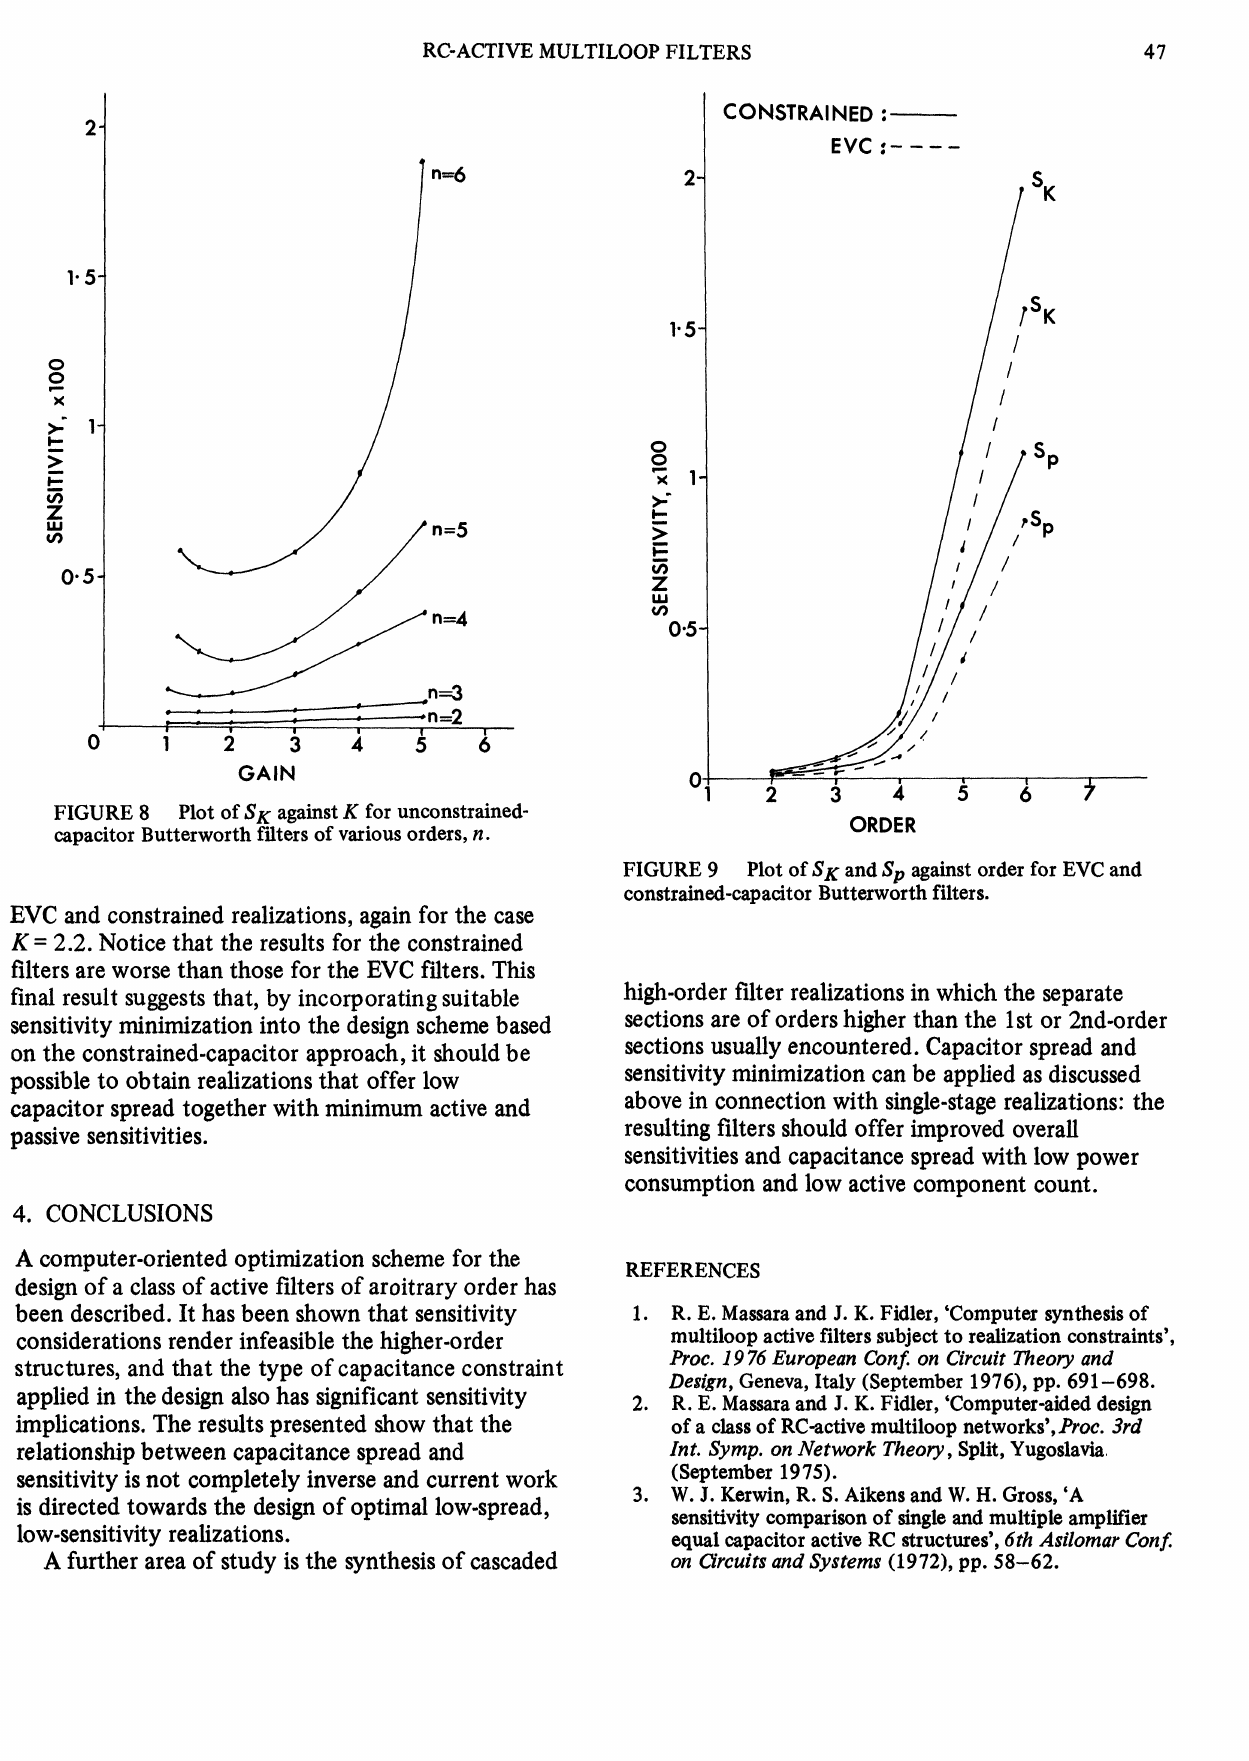
equal capacitor active RC structures’, 6th Asilomar Conf. on Crcuits and Systems (1972), pp.